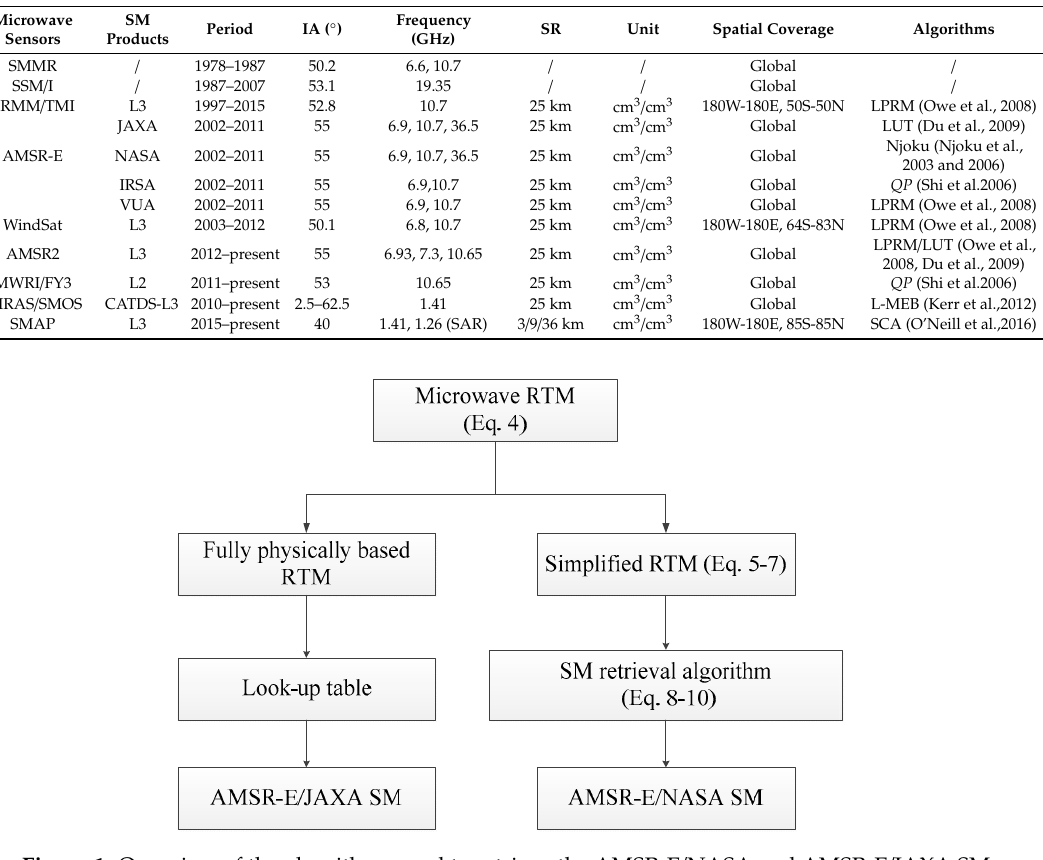
Figure 1. Overview of the algorithms used to retrieve the AMSR-E/NASA and AMSR-E/JAXA